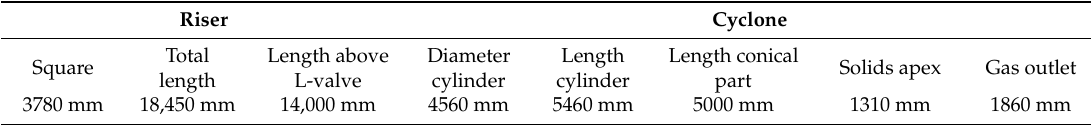
Table 3. Relevant dimensions of the